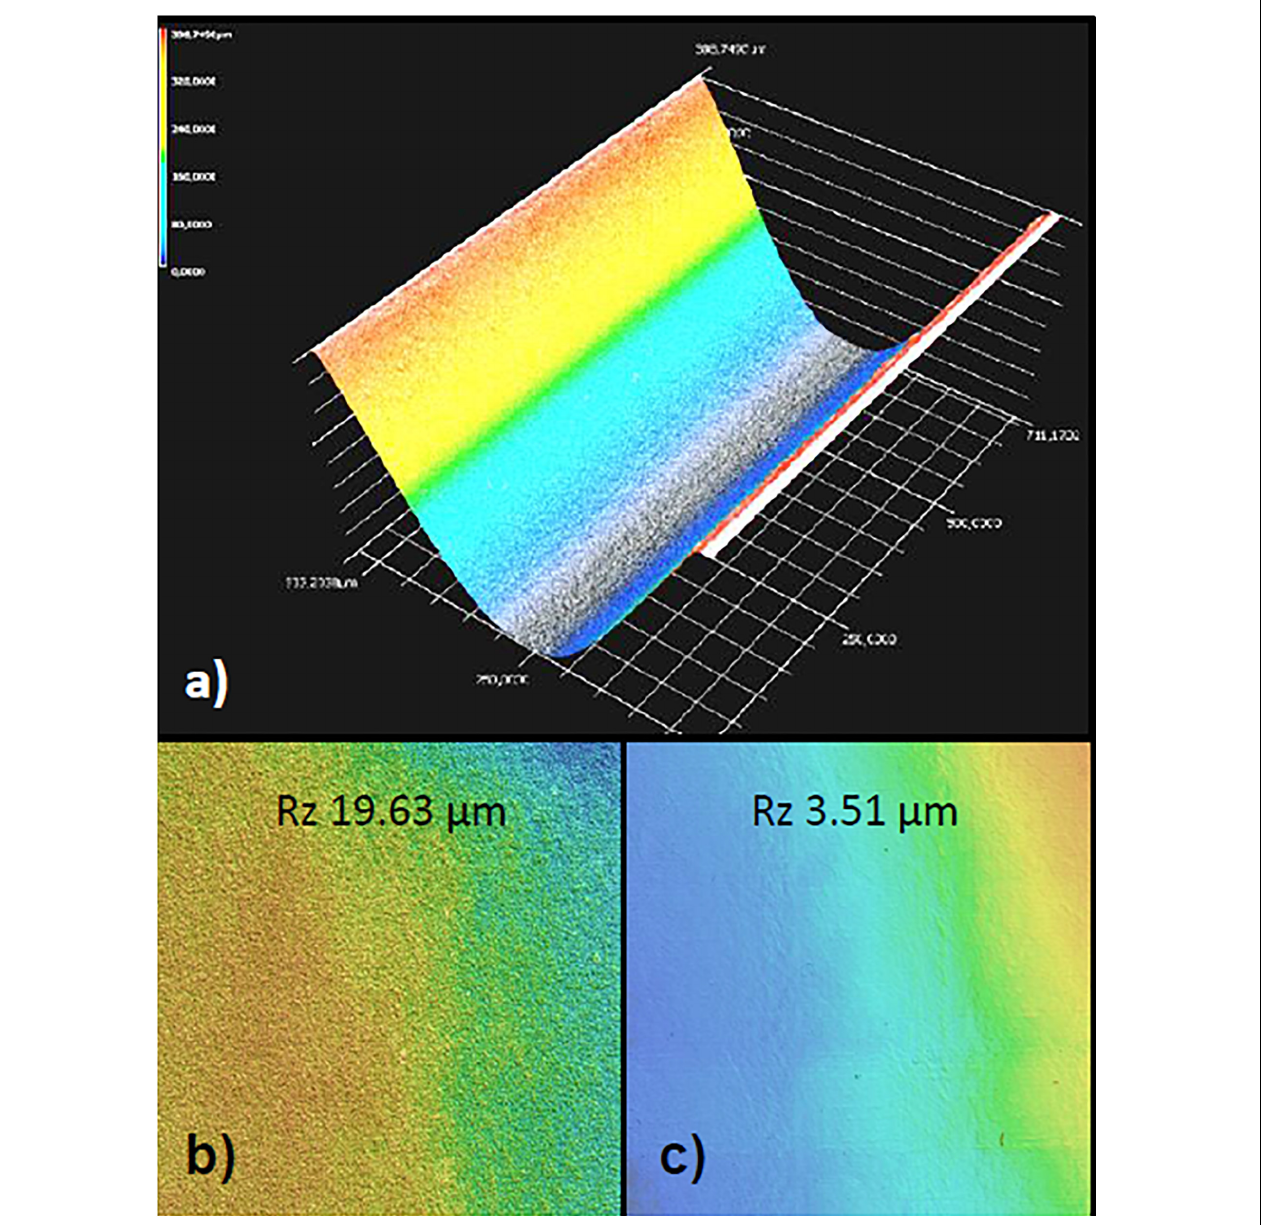
FIGURE 2 | Laser structuring of borosilicate glass. (a) 3D image of the microchannel generated by depth measurements after the ablation process and the blow-off of debris. The channel is contained in the upper half of the parallel perifusion slide and is seen here from below. Note the nearly paraboloid shape which was intended to minimize turbulent flow in the channels. (b) Surface of the channel wall after wet cleaning procedure before bonding. Note the residual roughness of the glass surface as given by the Rz value of nearly 20. (c) Heating of the glass chip to just below the melting temperature reduced the surface roughness more than